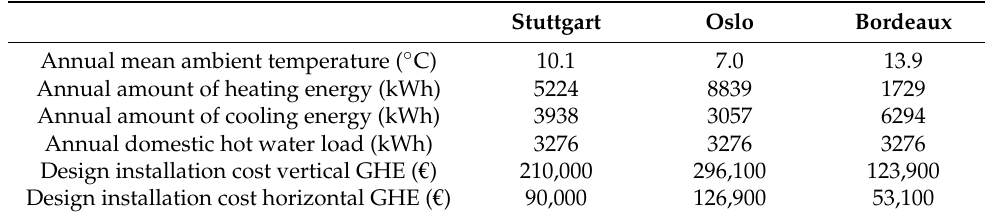
Table 9. Comparison between the three